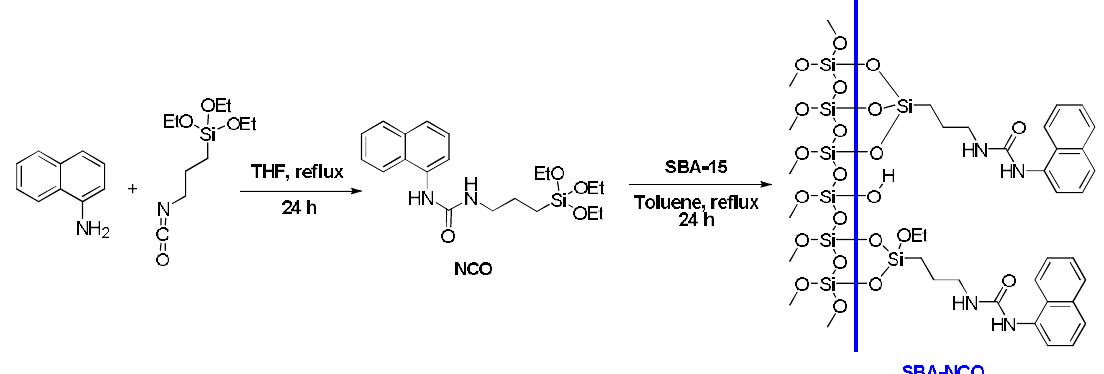
Fig. 19. Synthesis procedure of SBA-NCO.